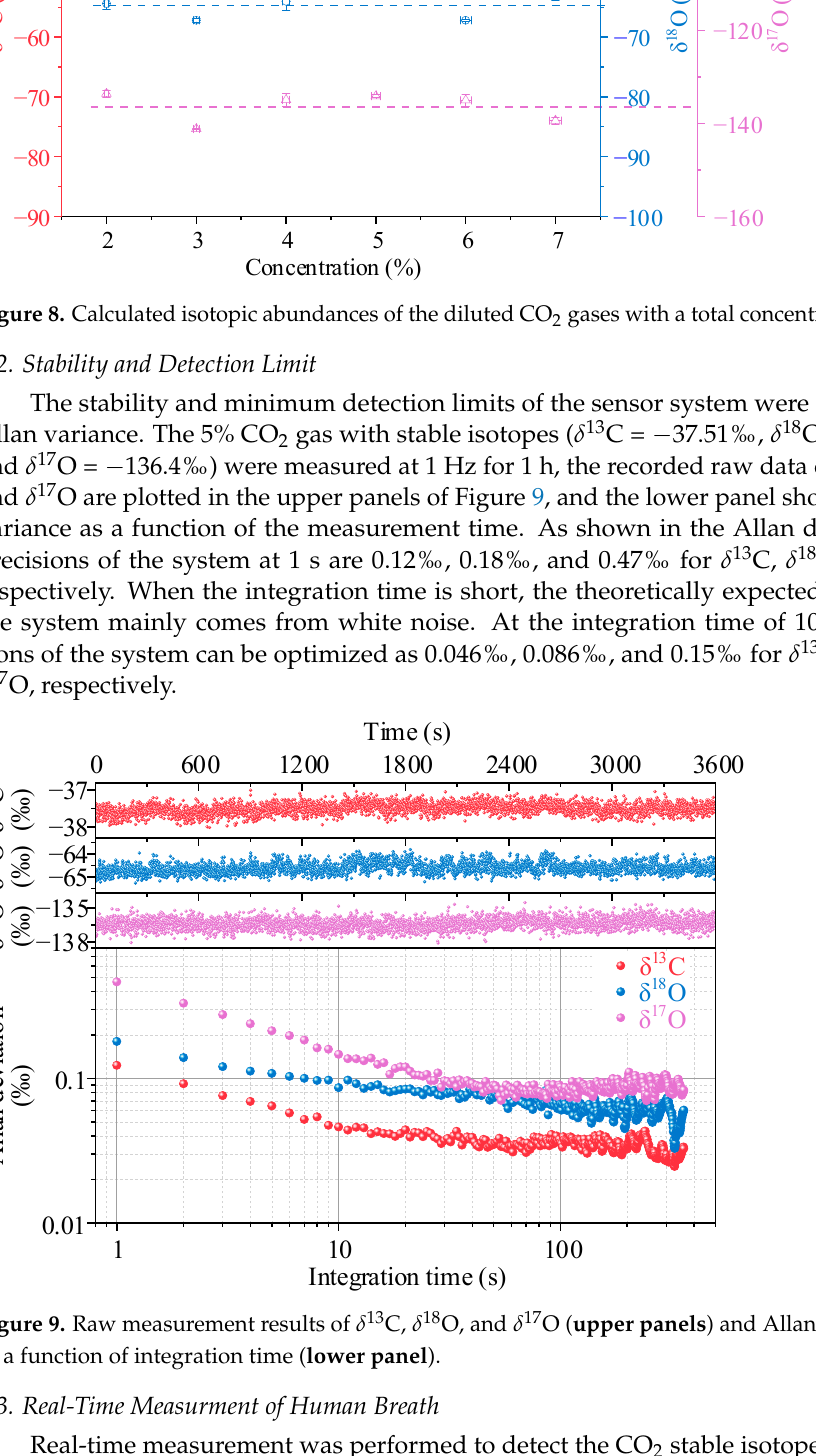
Figure 7. Measured absorption signals of CO 2 stable isotopes with a total concentration of 2%–7%.